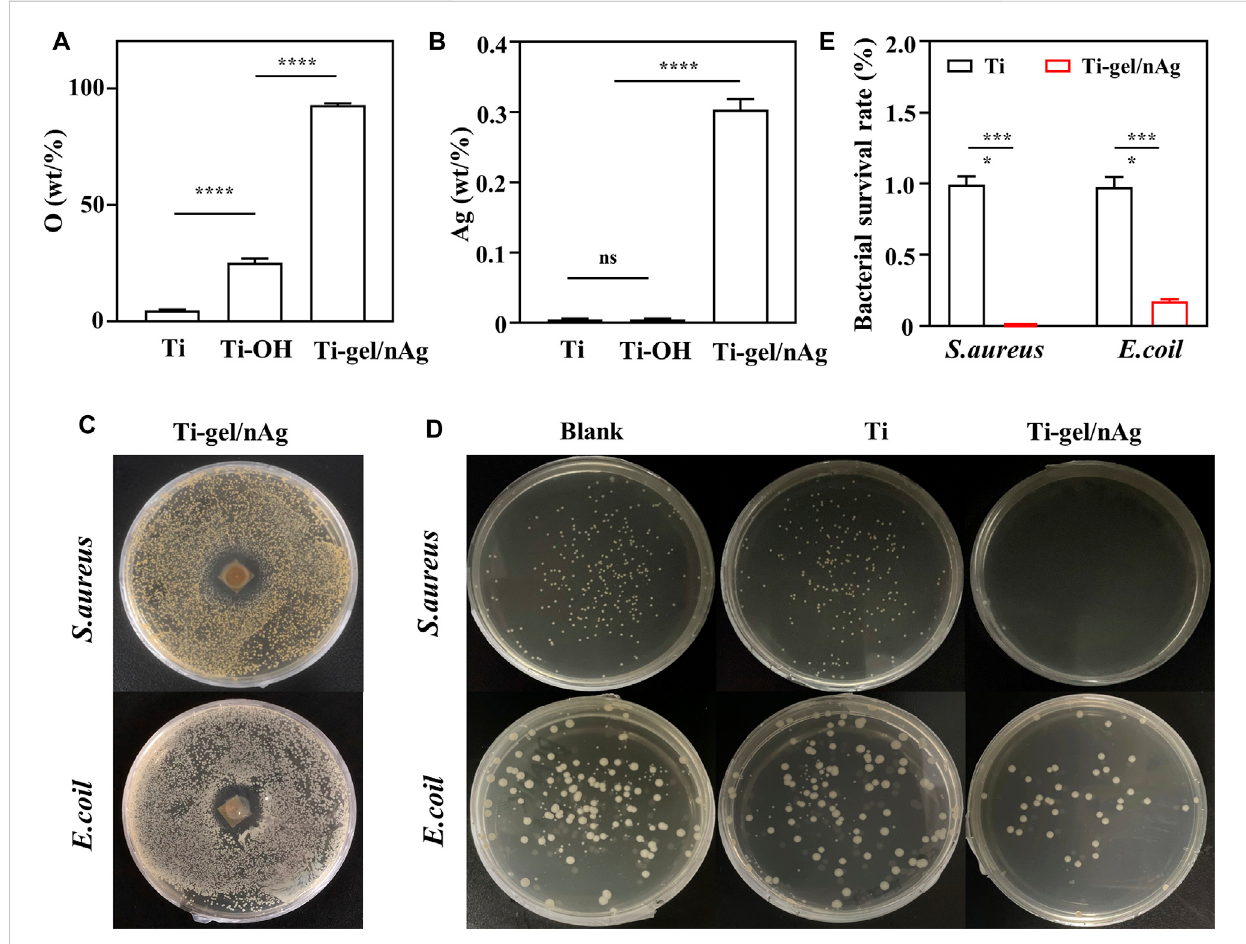
FIGURE 2 The surfaceelemental composition and antibacterial capacity of Ti and Ti-gel/nAg. (A) Relative elemental O and Ag (B) content of Ti, Ti-OH, and Ti- gel/nAg. (C) Inhibition zone of Ti and Ti-gel/nAg after co-culture with S. aureus/E. coil for 12 h (D) CFU of Ti and Ti-gel/nAg after co-culture with S. aureus/E. coil for 12 h (E) Bacterial survival of Ti and Ti-gel/nAg after co-culture with S. aureus/E. coil for 12 h (n = 3, ns means no signi fi cant difference, *** p <